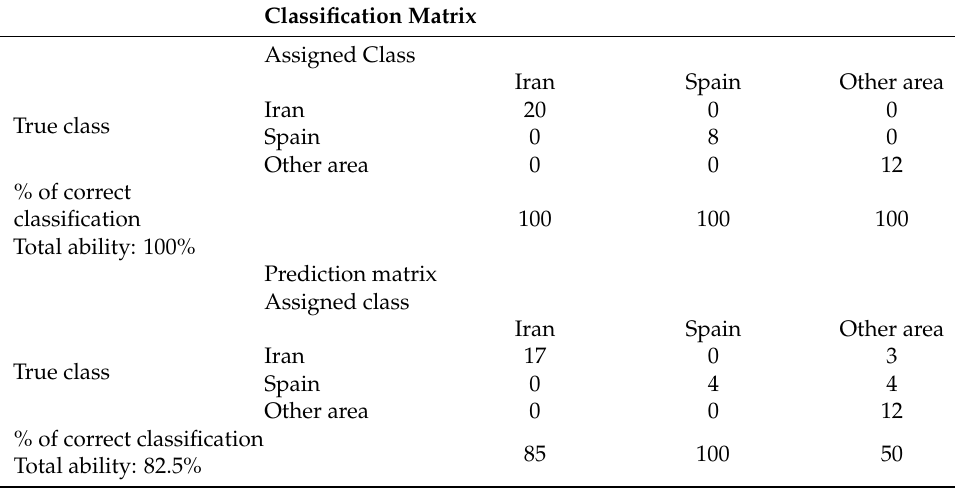
Table 4. Confusion matrices displaying the classification performance of QDA applied to saffron extract samples from three geographical